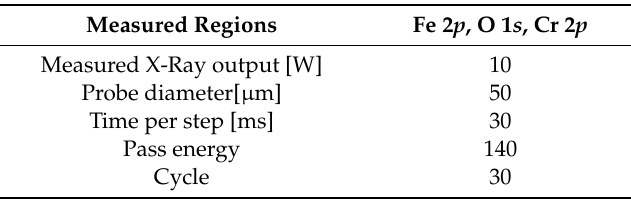
Table 2. XPS parameter for substrate oxide layer